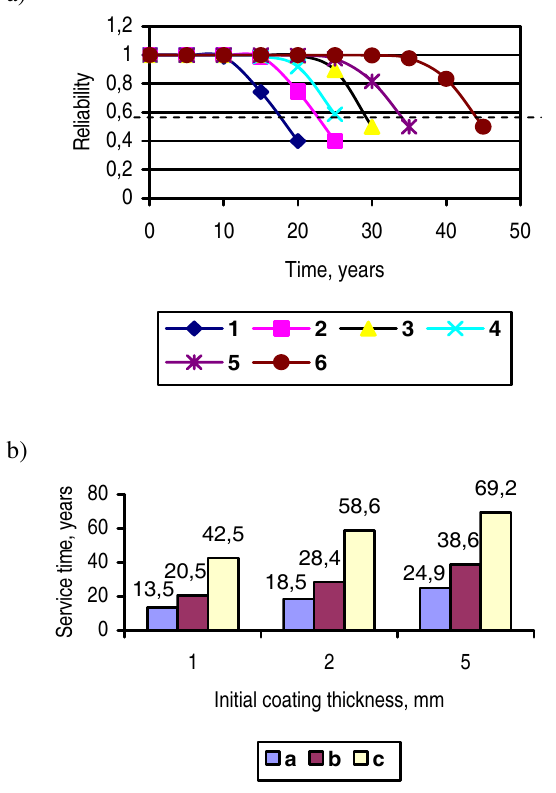
Fig 3 . Effect of coating thickness d pc (1 and 4 − 1 mm; 2 and 5 – 2 mm; 3 and 6 – 5 mm) on the reliability (a) and service life (b) of polymer coatings in H 2 SO 4 , 10 % (1, 2, 3) and NaOH, 10 % (4, 5, 6) 10 % solutions; a – H 2 SO 4 , 10 %; b – NaOH, 10 %; c – NaCl